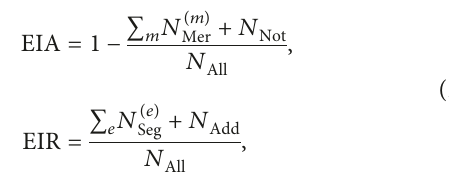
Figure 4(c): it usually results from too short dwell time at the trip end.